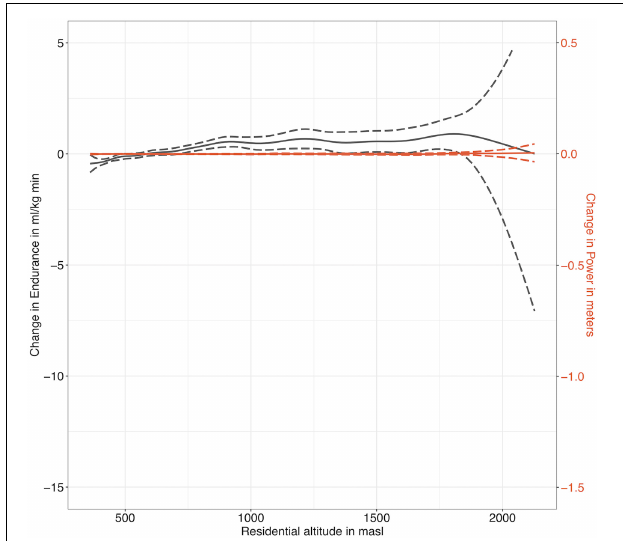
FIGURE 1 | Smoothed association between residential altitude and endurance (VO 2max in black) as well as muscle power performance (Standing Long Jump in red) from adjusted GAM models, based on the full dataset after multiple imputation (dashed lines = 95% confidence intervals, masl = meters above sea level, the scales of the primary and secondary axes are chosen according to Figure 2 in order to ensure